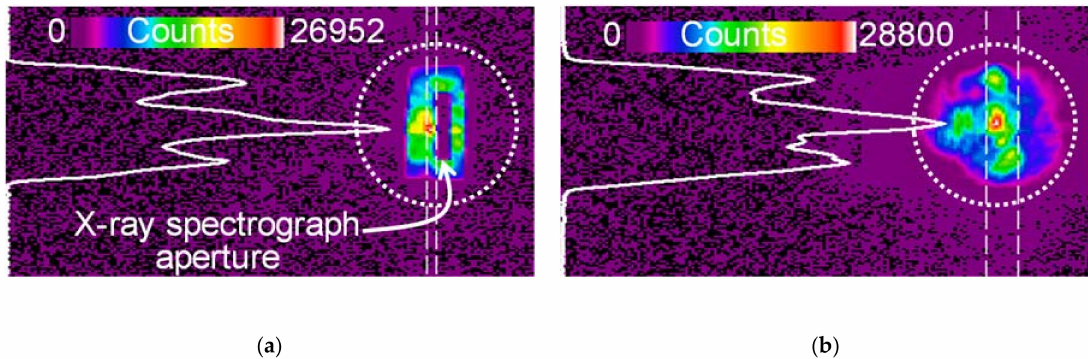
Figure 10. Transmitted footprints of the laser pulse on the Teflon screen situated at a distance of 63 cm after the gas jet (see Figure 1). The vertical lineouts on the left of the frames are drawn through the regions denoted with the dashed lines. The dotted circles have a diameter of 100 mm, i.e., an angular diameter of 9.1 ◦ . ( a ) The data taken simultaneously (the same shot) with the X-ray spectrum shown in Figure 9a; the dark rectangular area in the middle of the footprint corresponds to the aperture made in the screen to let the X-rays pass to the spectrograph; the footprint is clipped to the rectangular shape by other devices in the chamber. ( b ) The data obtained in the same experimental campaign as ( a ), but on another day, when the setup was modified to see the whole transmitted laser pulse